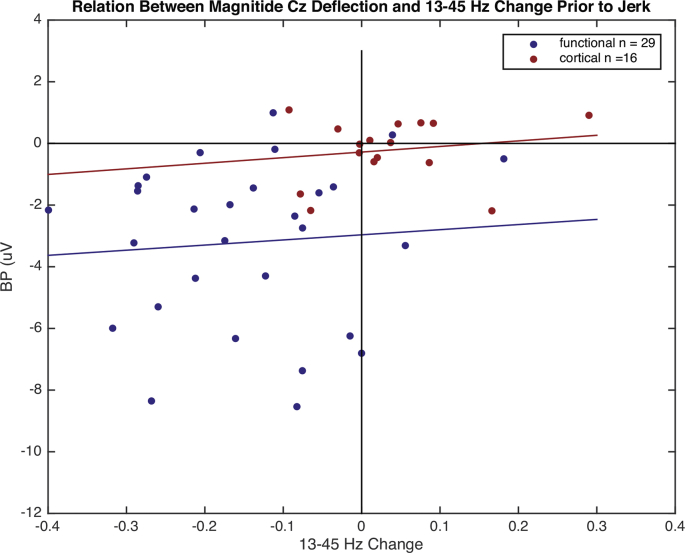
Upper panel: The relation between the amplitude of the quantified Bereitschaftspotential (BP) and its specificity (red) and sensitivity (blue, both in fractions) for discriminating functional jerks from cortical myoclonus. The horizontal bar indicate the values used in clinical practice for determining whether a BP is present which ranges from −5 μV to −2.5 μV. Middle panel: The relation between the change in relative central (Cz) EEG 13–45 Hz Power Spectral Density (PSD) prior to myoclonic jerks and its specificity and sensitivity for discriminating functional jerks from cortical myoclonus. Lower panel: The relation between the rank-based combination of BP and change in PSD and its specificity and sensitivity for discriminating functional jerks from cortical myoclonus. n.b. the rank is based on the average rank of BP and PSD in a cohort of 45 patients.